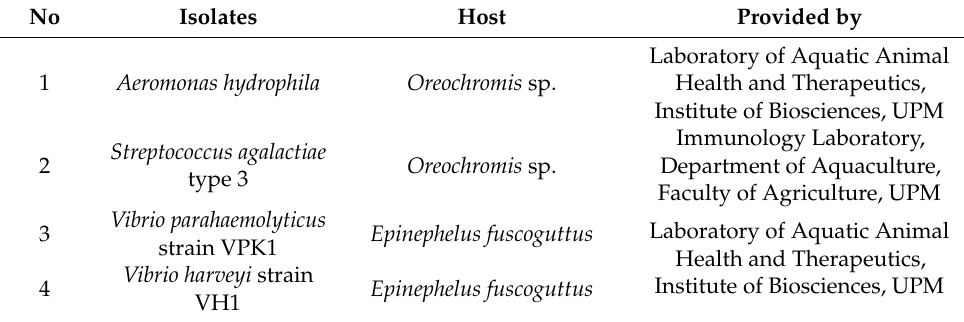
Table 2. List of pathogens used in the screening